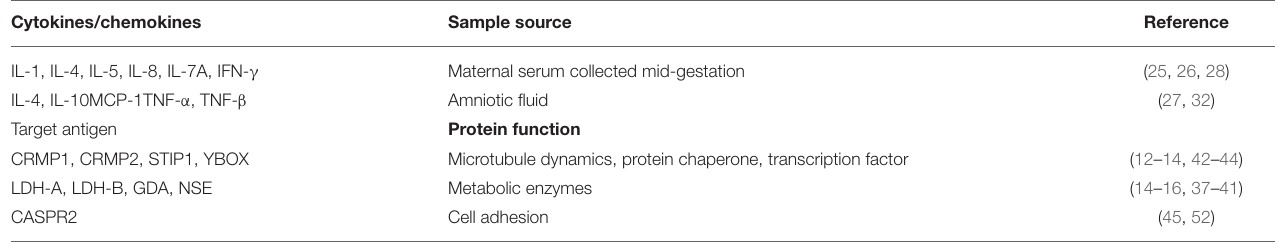
TABLE 1 | Maternal cytokines/chemokines and maternal autoantibody targets implicated in ASD.